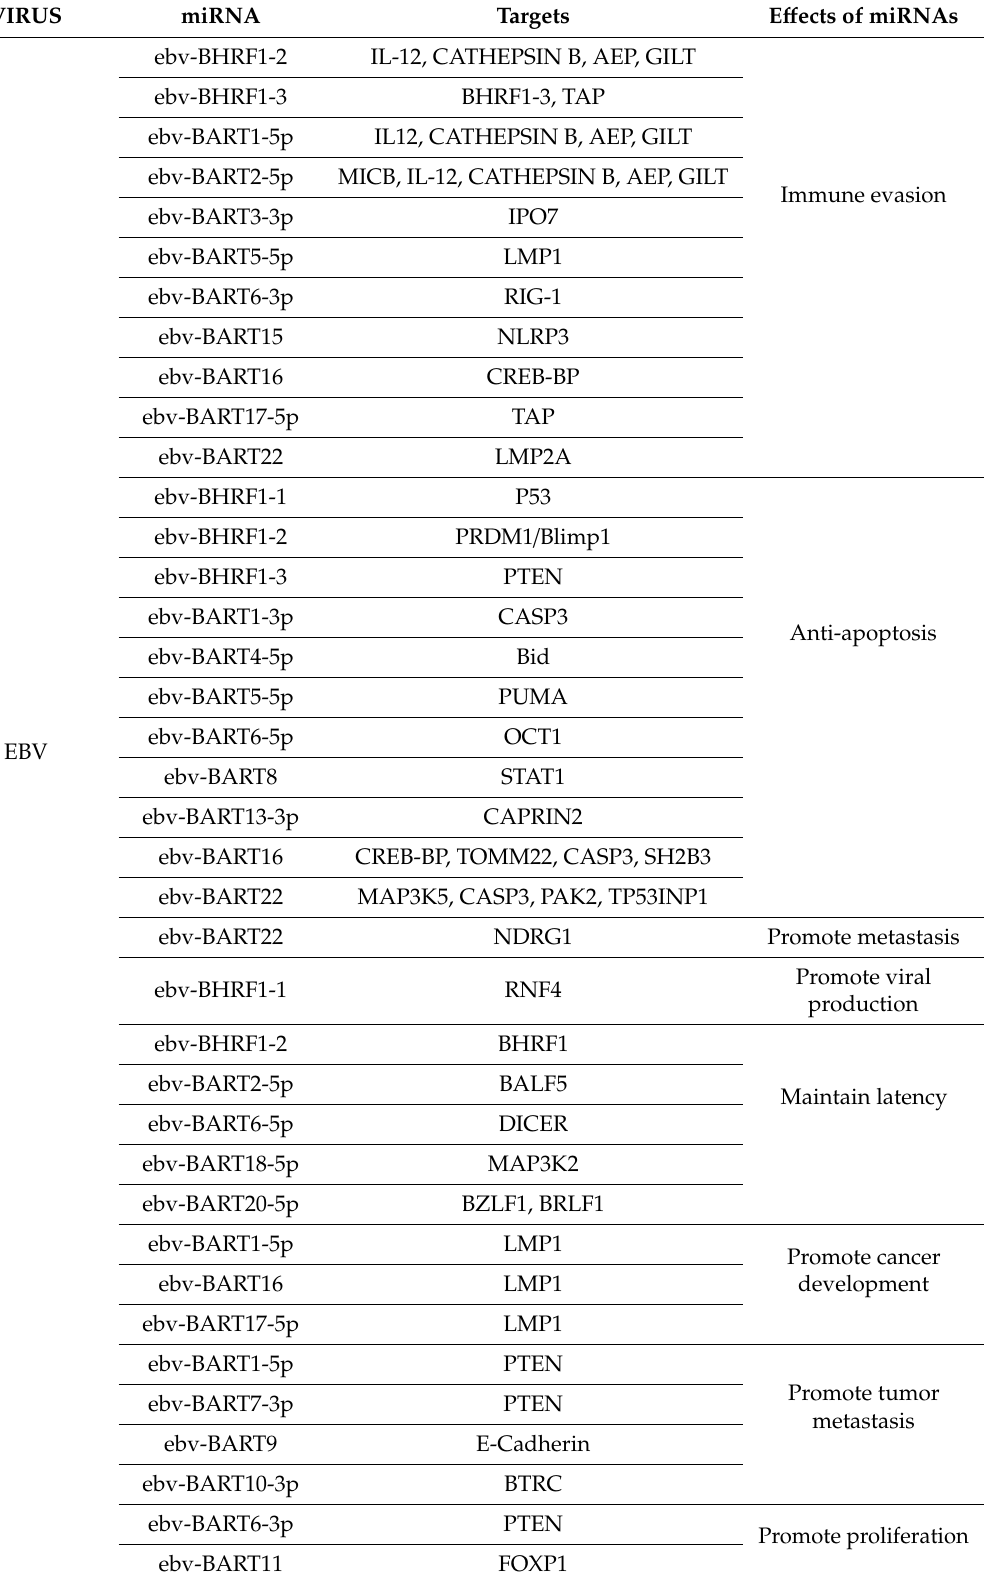
Table 1. Overview of viral miRNA regulatory functions and